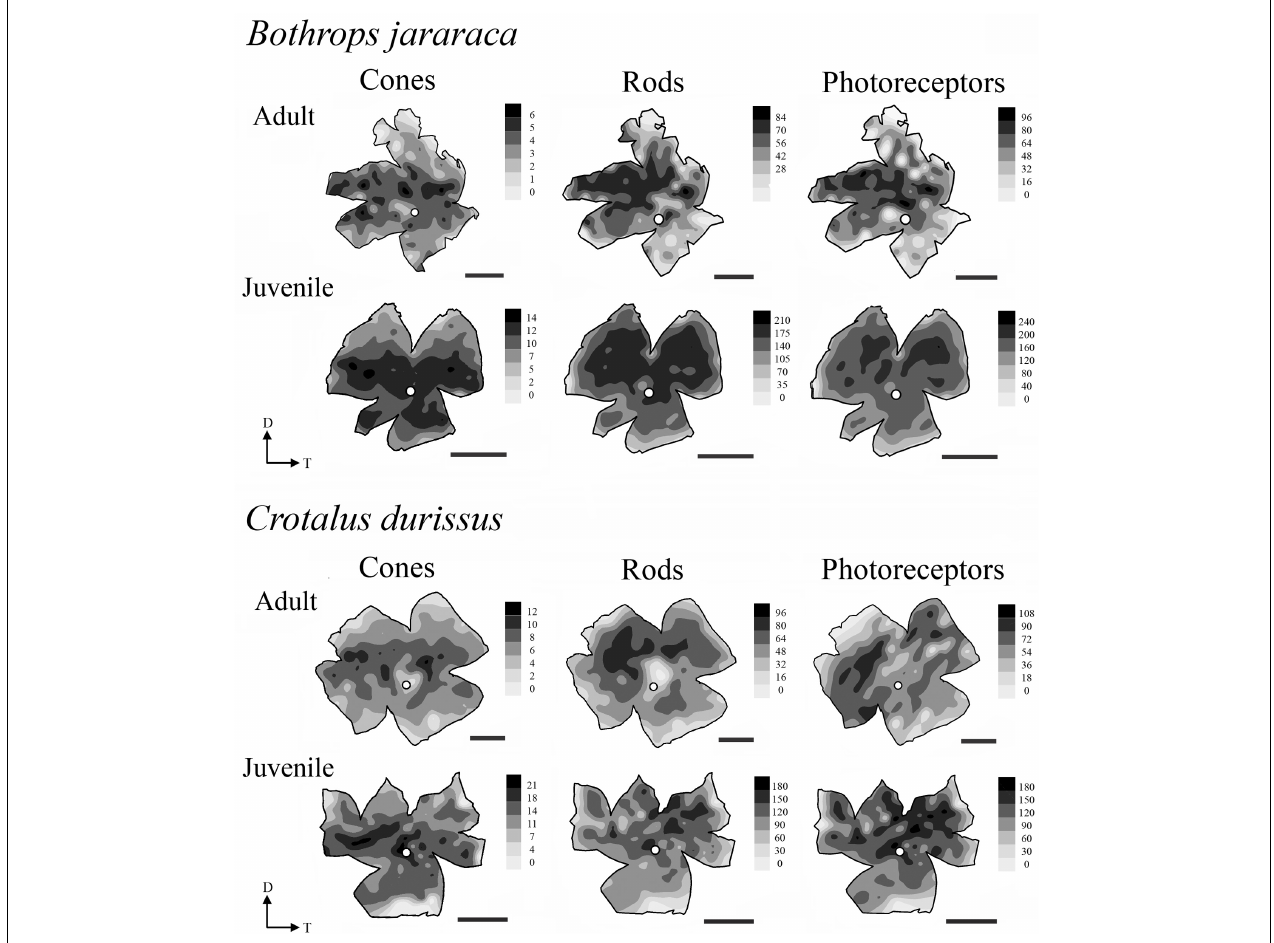
FIGURE 7 | Representative topographic maps of the retinas of B. jararaca and C. durissus , showing the distribution of cones, rods, and photoreceptors in adults and juveniles. In adults of B. jararaca , both rods and cones form poorly defined visual streaks. In juveniles, rods are concentrated in a dorsal area and cones in a ventral area . In retinas of adults and juveniles of C. durissus rods are concentrated in anisotropic area centralis in the dorsal retina, and cones are arranged in poorly defined visual streaks. Gray bars indicate the density of cells per mm 2 , and the values should be multiplied by 10 3 . The optic nerve head is depicted as a white circle. D, dorsal; T, temporal. Scale bars 2